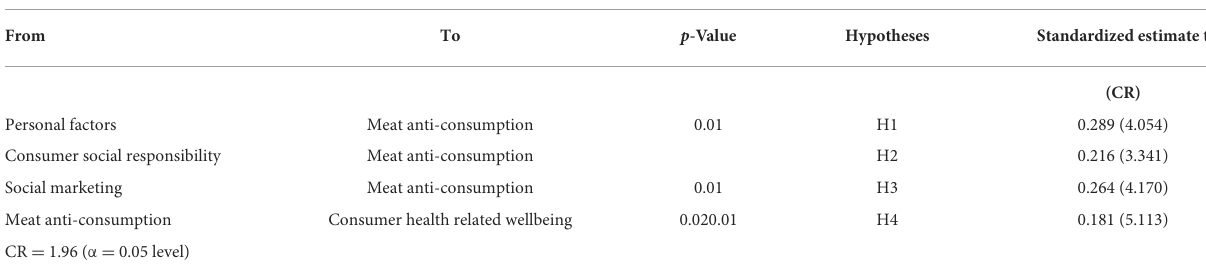
TABLE 3 SEM estimates.